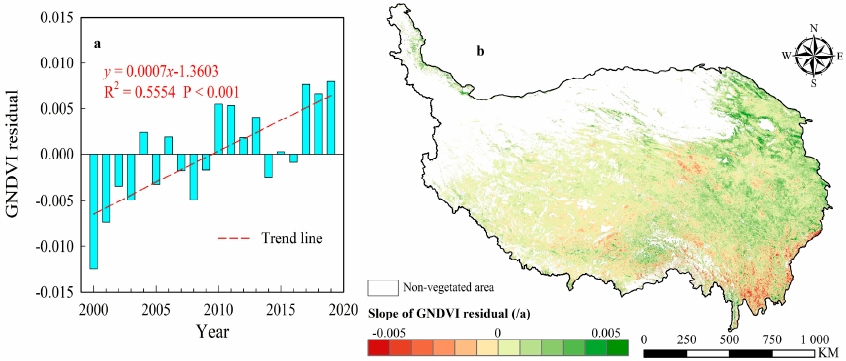
Figure 10. ( a ) The GDNVI residual variation of the whole QTP and ( b ) its spatial pattern during 2000–